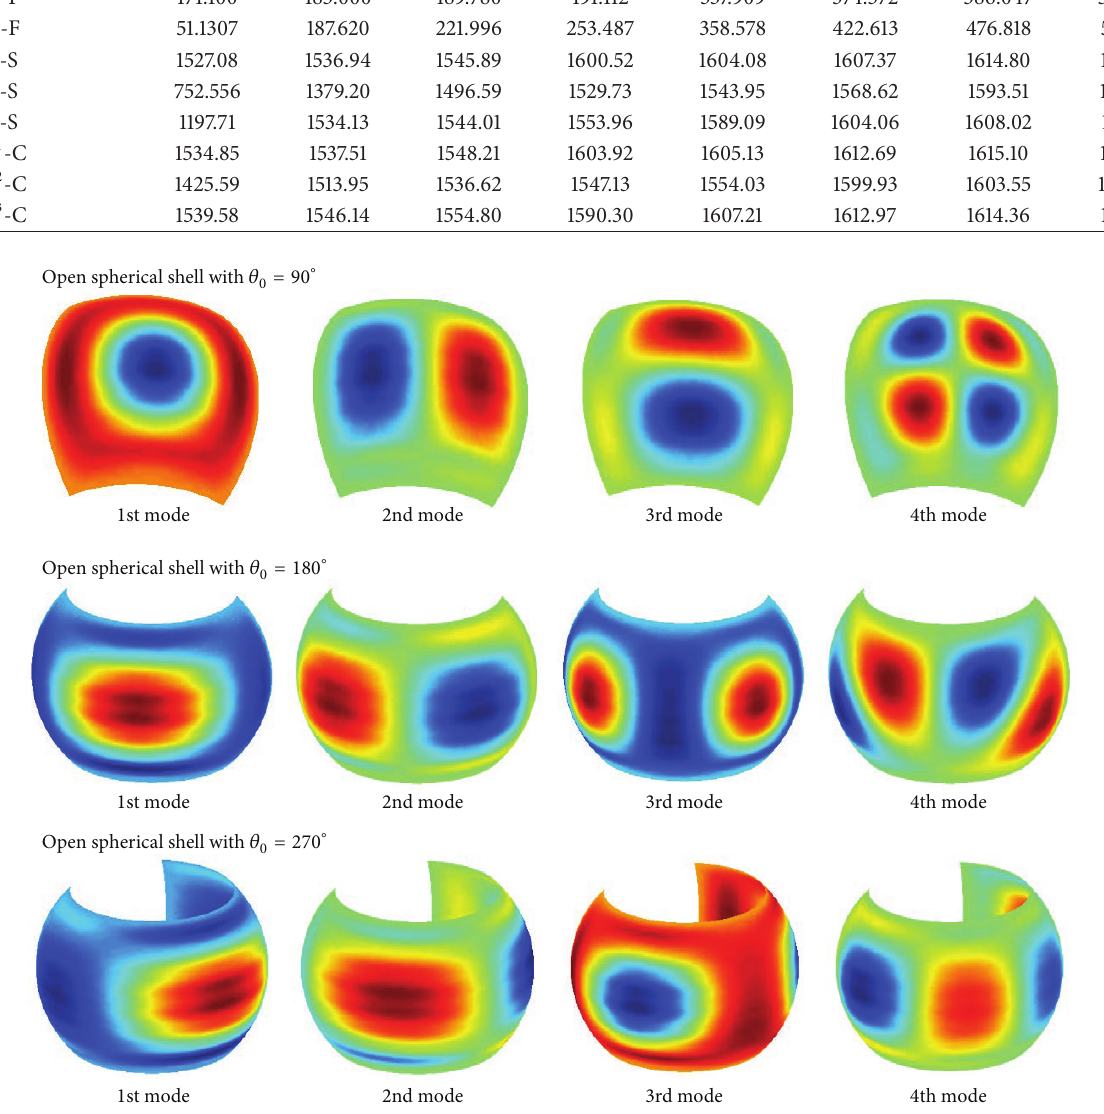
Figure 8: First four mode shapes for an open spherical shell with E 1 -C-E 1 -C boundary